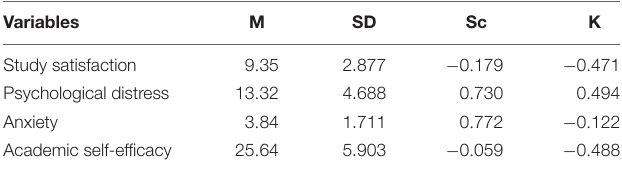
TABLE 3 | Correlation between study satisfaction, psychological distress, anxiety, and academic self-efficacy.